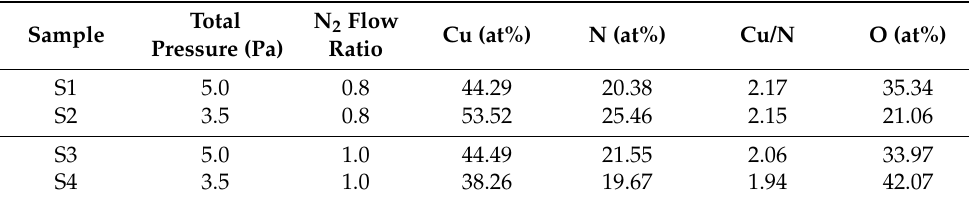
Table 3. Relative surface composition of the films under study, derived from the EDS analysis.